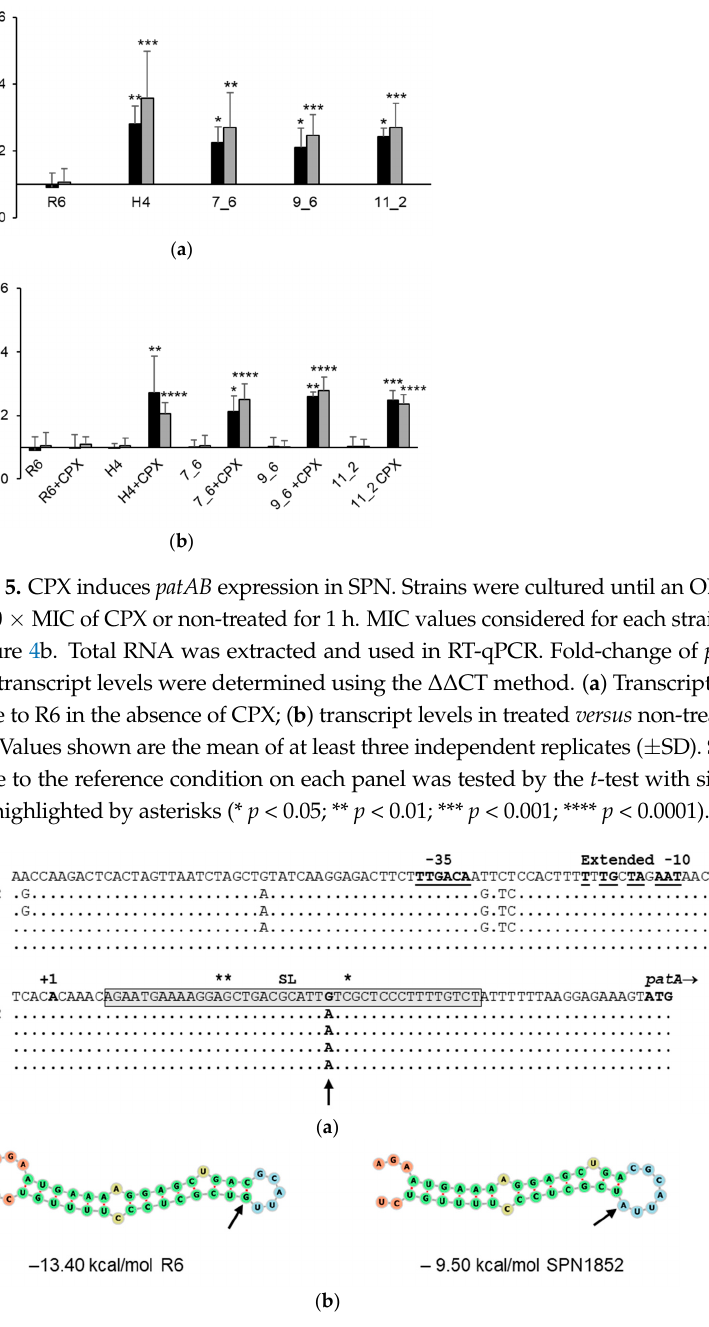
Figure 6. Sequence features of patAB upstream region. ( a ) Nucleotide sequence alignment of the intergenic region between hexA and patA of strains R6, SPN1852, and the indicated PCR transformants. R6 sequence is shown. Identical nucleotides are illustrated by a dot and only nucleotide differences are displayed. The putative − 35 and extended − 10 sequences of the promoter are underlined and the start codon (ATG) of patA is shown in boldface. The transcriptional start site (+1) identified previously [32] is indicated in bold, and the nucleotide sequence of the SL as predicted by RNA-fold is delimited by a gray rectangle. Asterisks denote location of mutations identified previously at the SL; ( b ) diagram showing the predicted secondary structure at the 5’-end of patA transcript of SPN1852 and SPNR6 strains by RNA-fold minimum free energy prediction. Bases are colored by structure according to the following scheme; green: stems, yellow: interior loops, blue: hairpin loops and orange: 5’ and 3’ unpaired region. The corresponding free energies are shown. G + 31 ⟶ A mutation is labelled by an arrow.